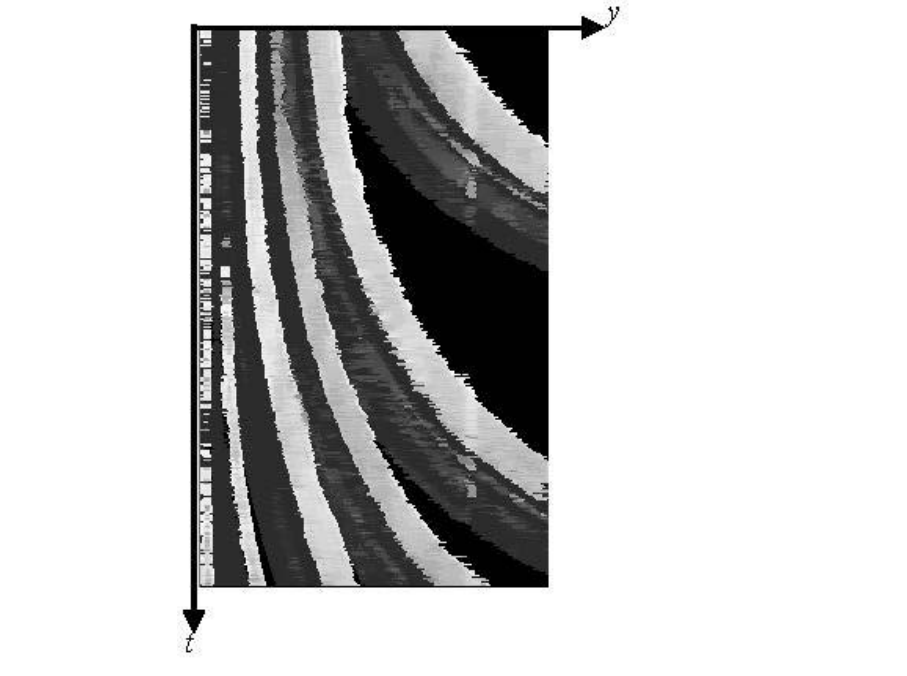
Figure 14. A spatio-temporal image